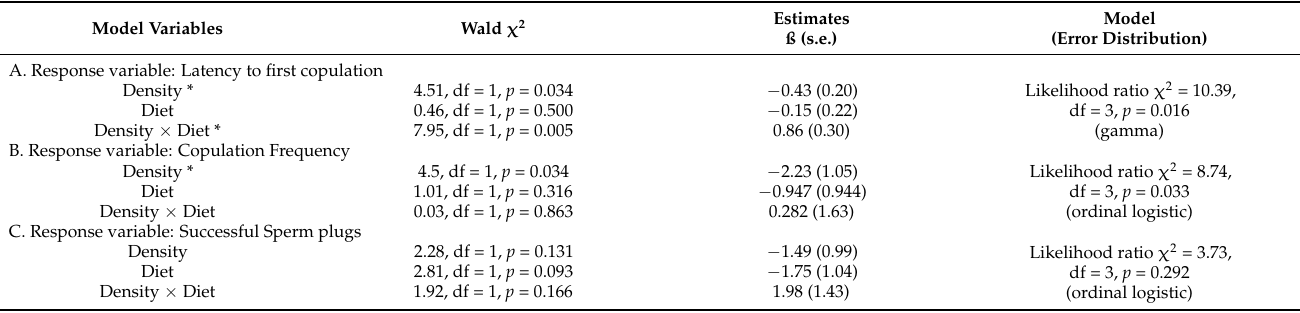
Table 1. Outcome of the generalized linear model tests of the effects of the male density and diet during development for adult females that copulated in mating trials in terms of latency to copulation (A), copulation frequency (B) and plug placement